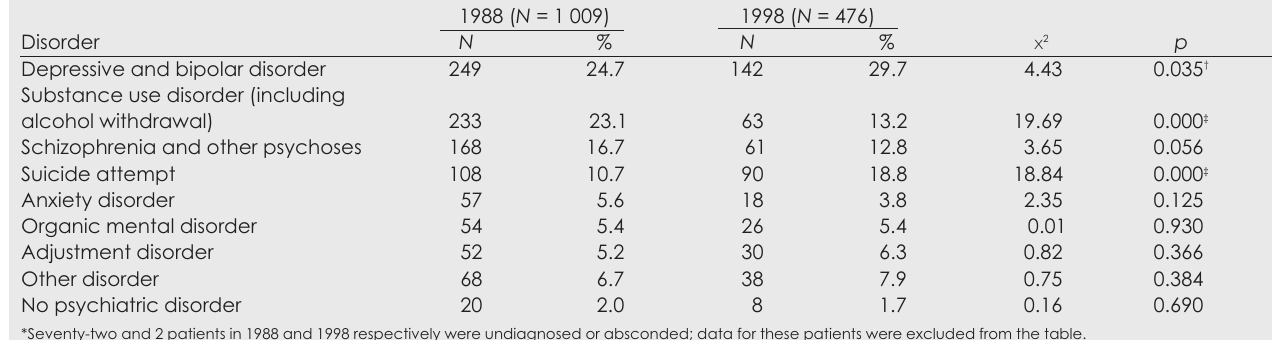
Table II. Primary diagnosis of patients attending the psychiatric emergency services unit, Groote Schuur Hospital, 1988 and